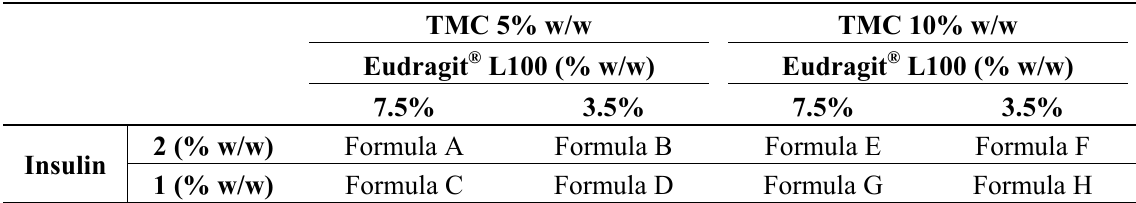
Table 1. Microsphere formulations A–H as defined by the fractional factorial design.